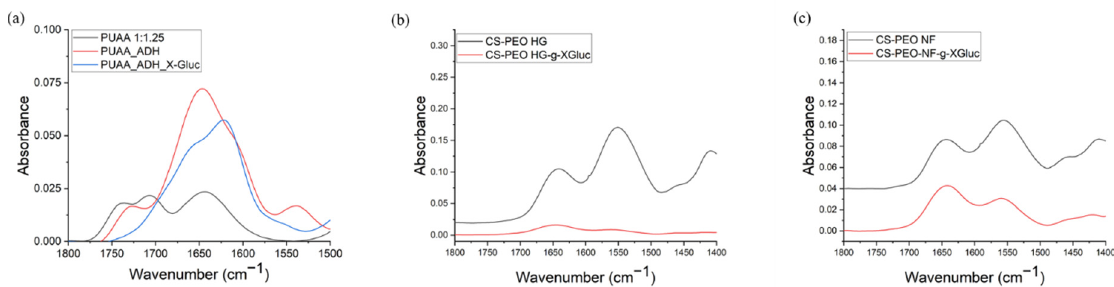
Figure 5. ATR-FTIR spectra of a) PUAA-ADH hydrogel films b) CS/PEO hydrogels and c) CS/PEO NFs.